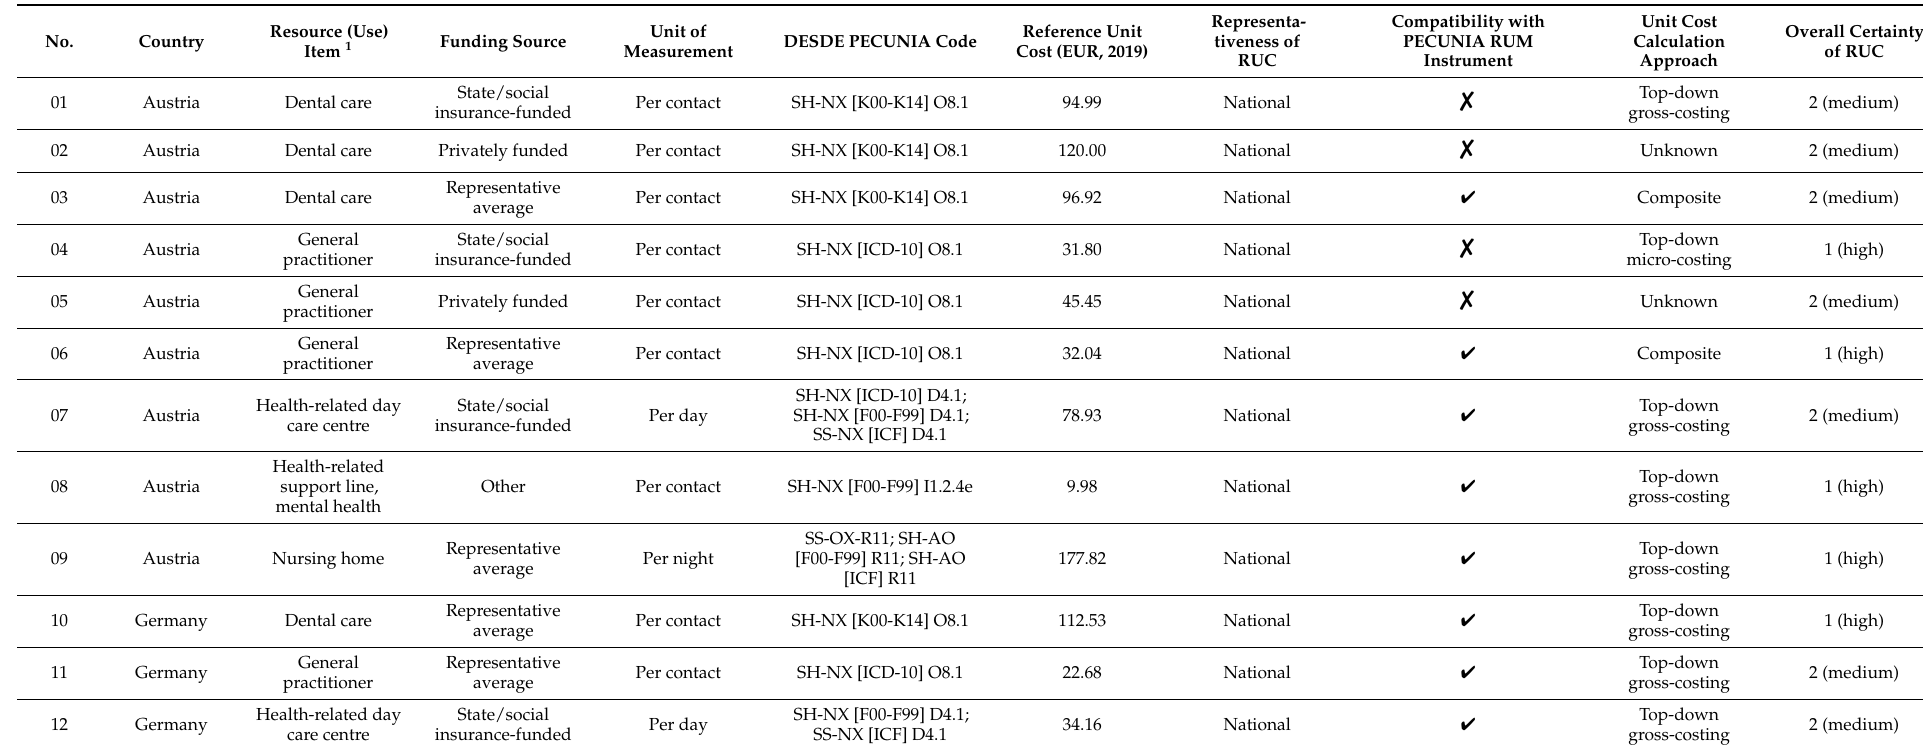
Table 2. Summary of the 36 PECUNIA Reference Unit Cost (RUC) estimates for health and social care services (in EURO, for year 2019). No. Country